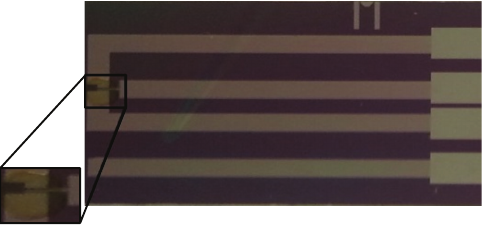
Figure 16: Glucose sensor after functionalization.